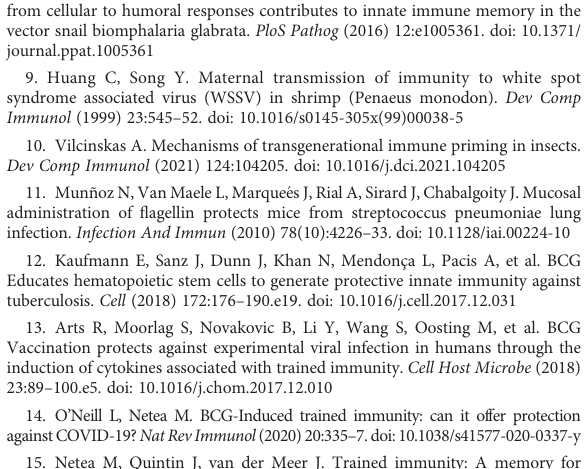
position are marked.